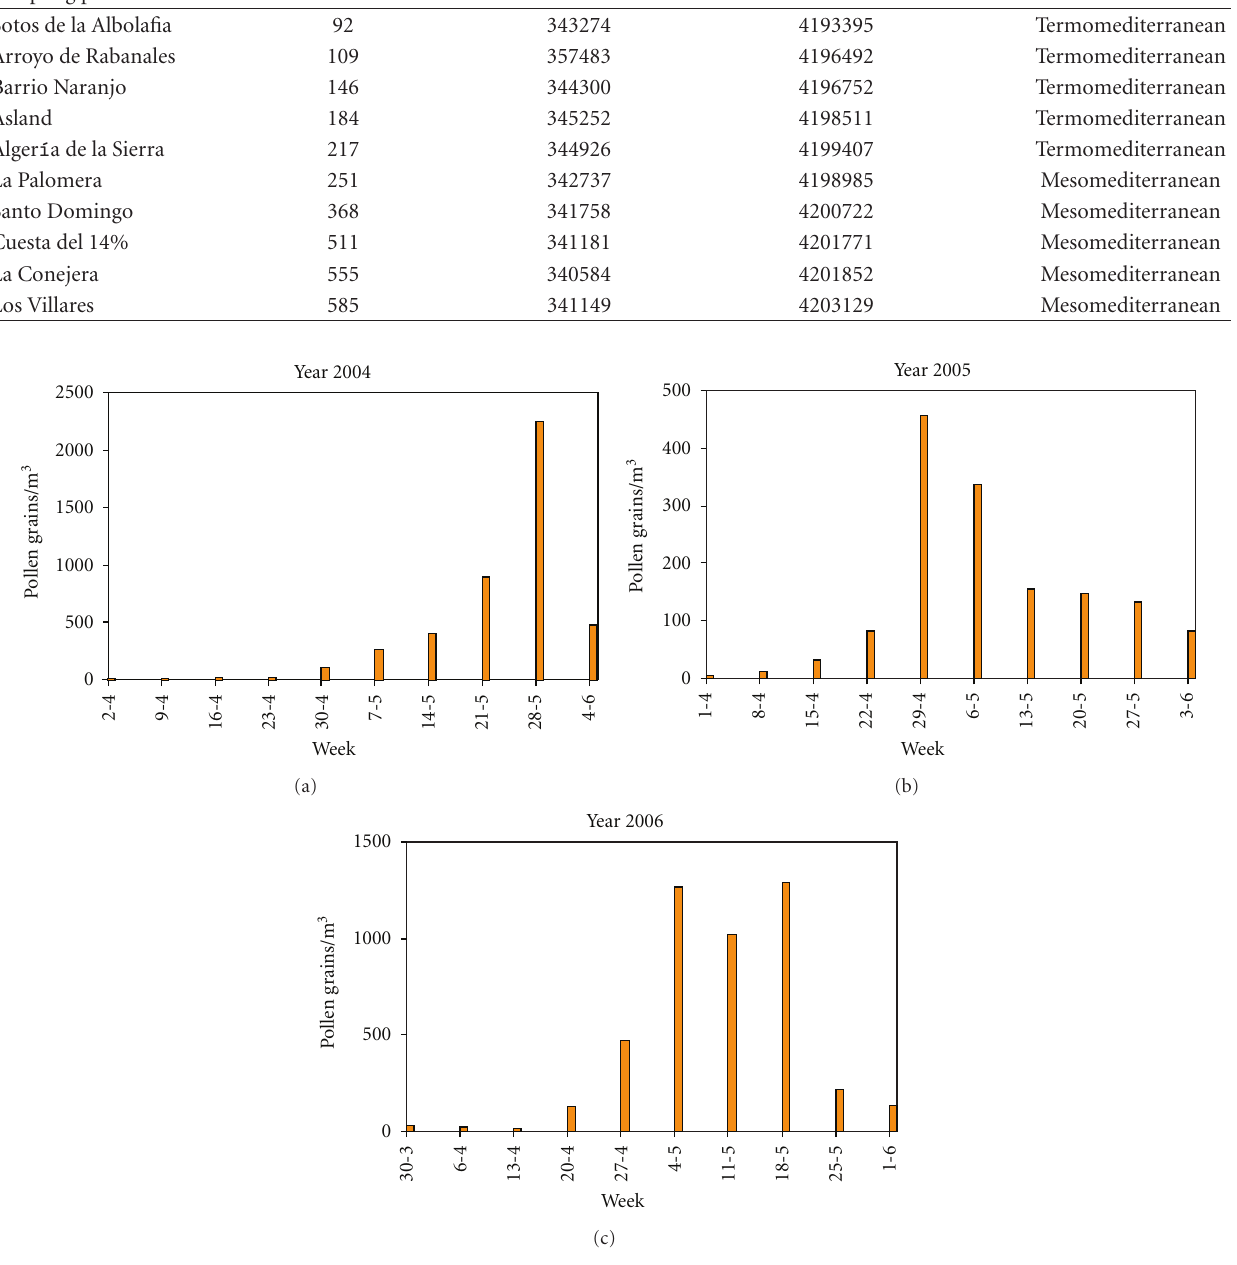
Figure 2: Poaceae airborne pollen cumulated per week during the study